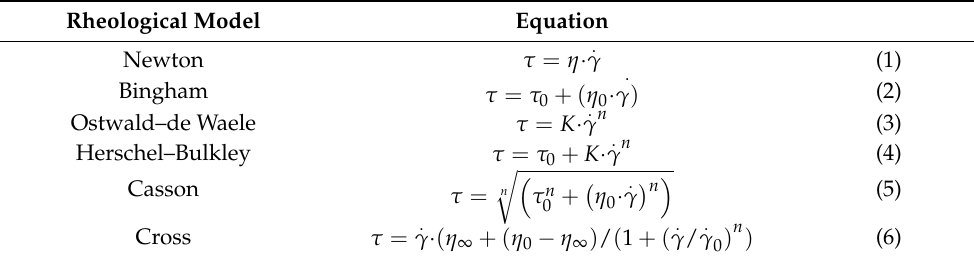
Table 1. Rheological equations used to evaluate the prepared